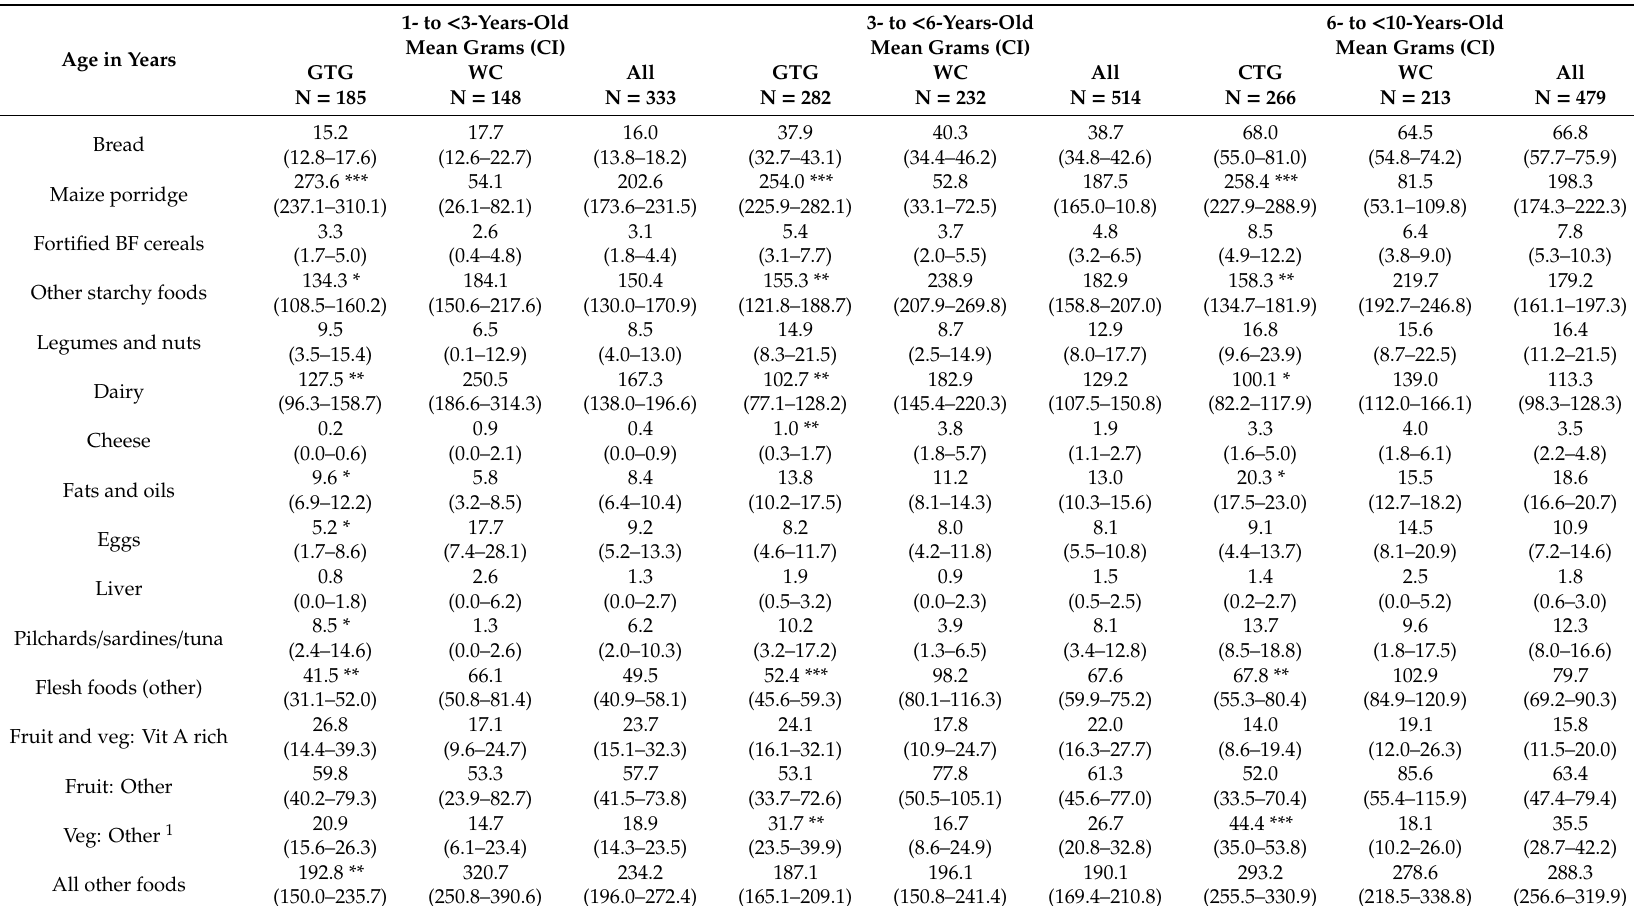
Table 7. Mean (CI) per capita intake (g) of the adapted Food and Agriculture Organization–Food and Nutrition Technical Assistance Project (FAO–FANTA) [30] food groups of children aged 1 to < 10 years by age and